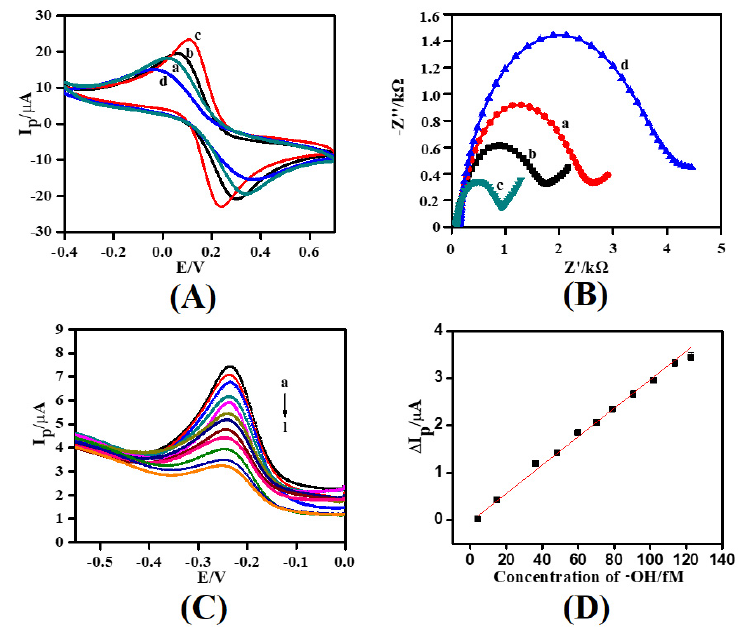
Figure 4. ( A ) CVs of (a) chitosan/GCE, (b) bulk- g -C 3 N 4 /chitosan/GCE, (c) carboxylated- g -C 3 N 4 /chitosan/GCE and (d) ssDNA/carboxylated- g -C 3 N 4 /chitosan/GCE in the 1 mM [Fe(CN) 6 ] 3 − /4 − (1:1) solu ‐